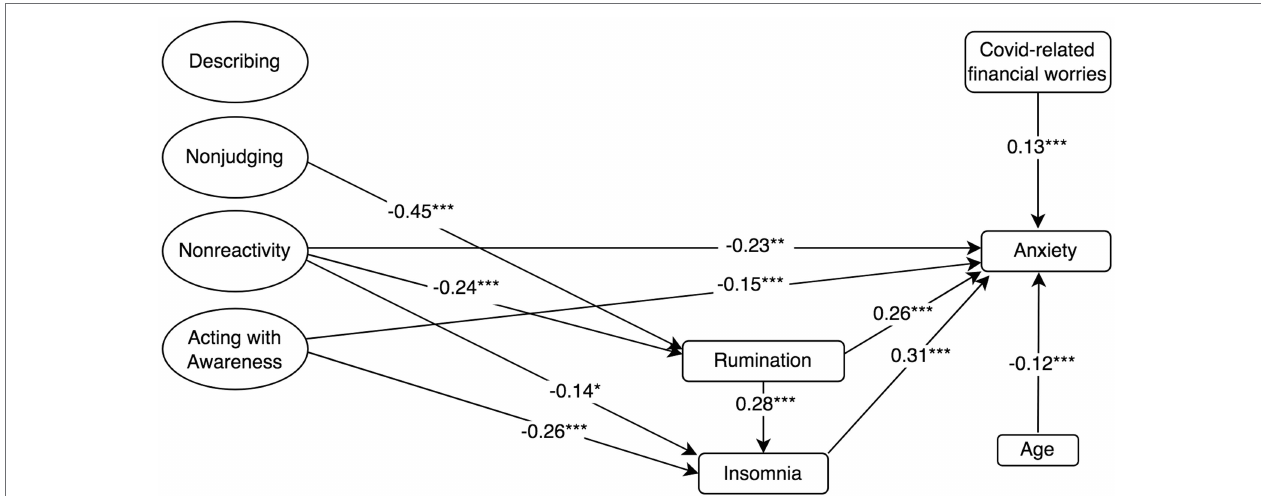
FIGURE 5 | Standardised mediation Model 5 of the effect of the five facets of mindfulness on anxiety. Anxiety = GAD-7, a 7-item Generalised Anxiety Disorder; Rumination = RSS-SF, 10-item Rumination Response Scale-Short Form; Cognitive Reappraisal and Suppression = ERQ, 10-item Emotion Regulation Questionnaire; Insomnia = ISI, 7-item Insomnia Severity Index; and Mindfulness and facets = FFMQ-SF, 24-item Five-Facets Mindfulness Questionnaire-Short Form. † p < 0.10; * p < 0.05; ** p < 0.01; and *** p ≤ 0.001.